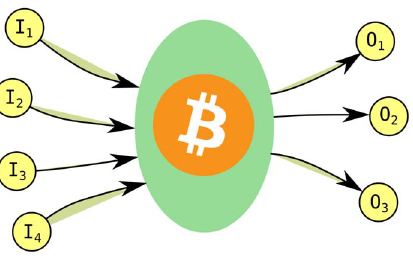
Figure 13. Schematic view of a Bitcoin transaction. Here we have four input (I 1 –I 4 ) and three output (O 1 –O 3 ) addresses. Links in our analysis are created pointing from each input to each output address.